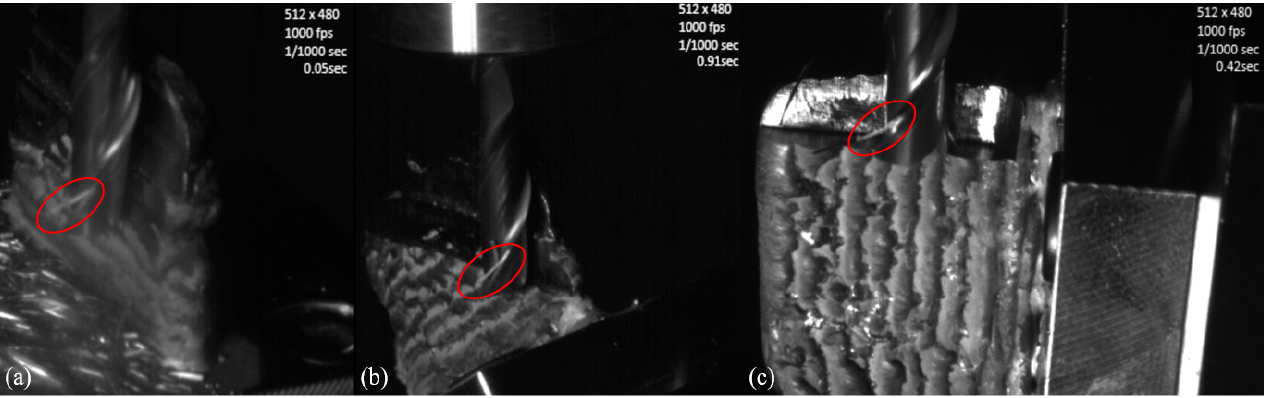
Figure 8. High ‐ speed camera pictures—( a ) 0 degrees, ( b ) 35 degrees, ( c ) 90 degrees .